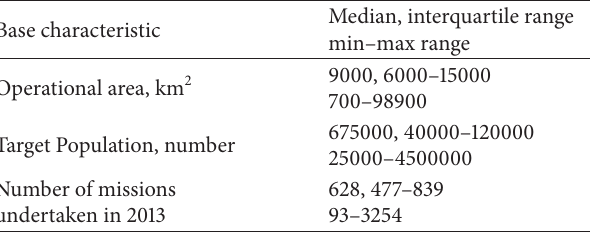
Table 1: Characteristics of HEMS bases.